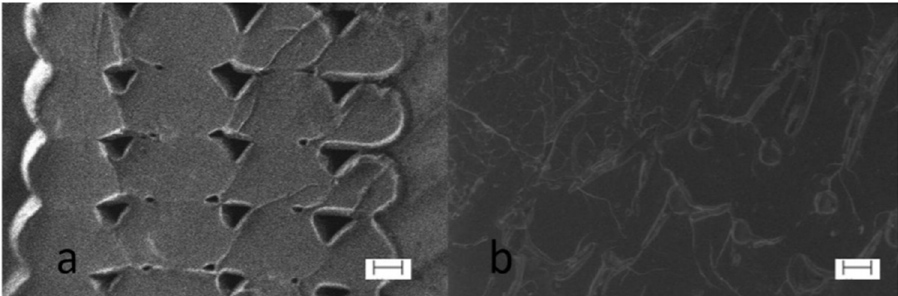
Figure 7. SEM images showing a decrease of air voids in printed PLA after adding low molecular weight polymer: ( a ) Neat PLA and ( b ) PLA-3%LMW polymer (scale bars equal 100 mm). Reprinted with permission from Ref. [55]. 2018, Elsevier.